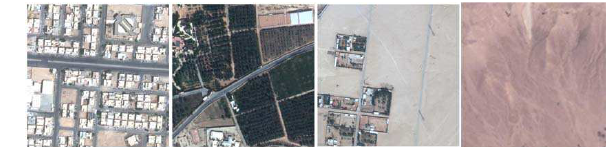
Figure 2. Samples of different landscape types